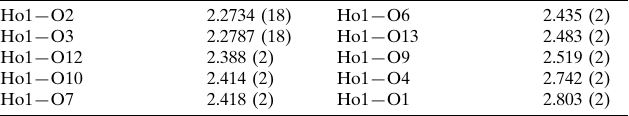
Selected bond lengths (A˚